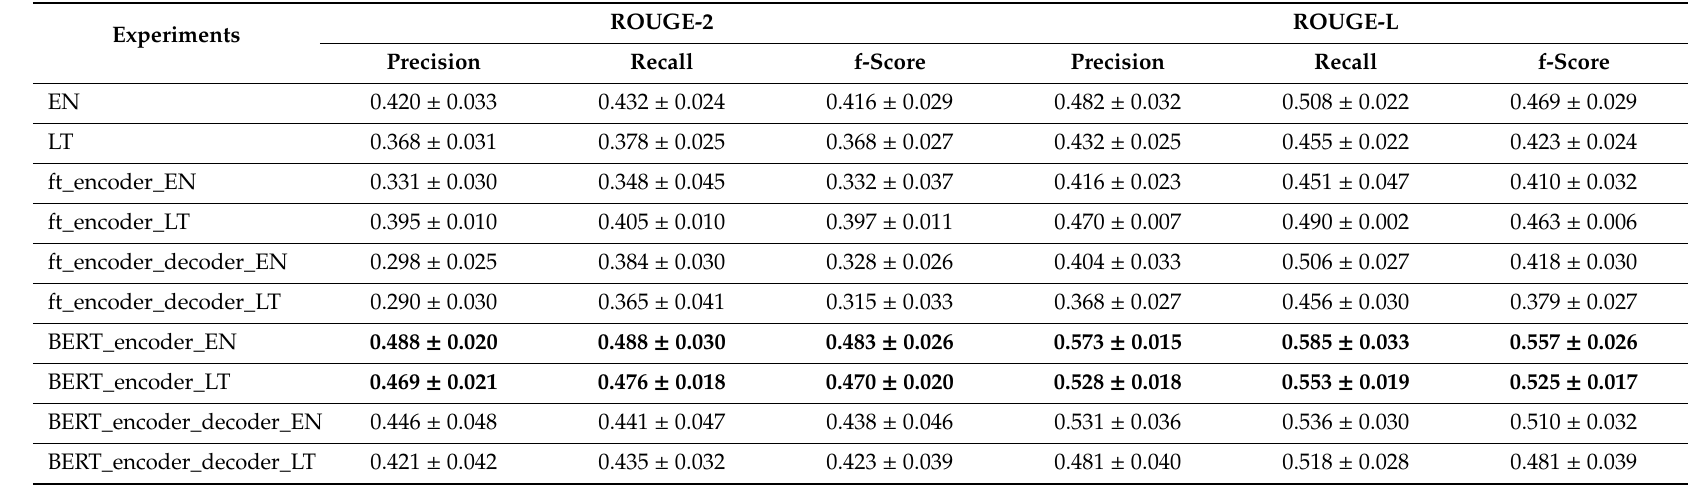
Table 4. Averaged ROUGE-2 and ROUGE-L precision / recall / f-score values with confidence intervals using the LSTM2 encoder and LSTM decoder model with di ff erent vectorization types on the dataset with removed punctuation. The best values in the column for EN and LT are in